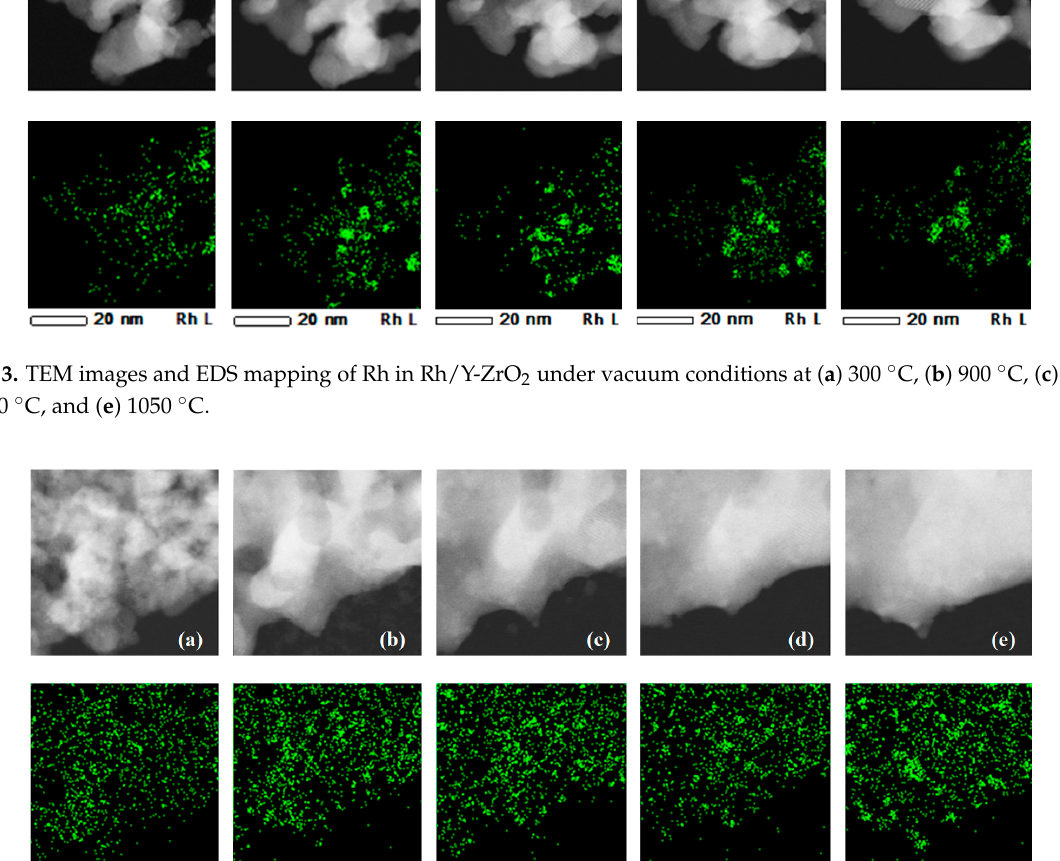
Figure 4. TEM images and EDS mapping of Rh in Rh/CeO 2 under vacuum conditions at ( a ) 300 °C, ( b ) 900 °C, ( c ) 950 °C, ( d ) 1000 °C, and ( e ) 1050 °C.